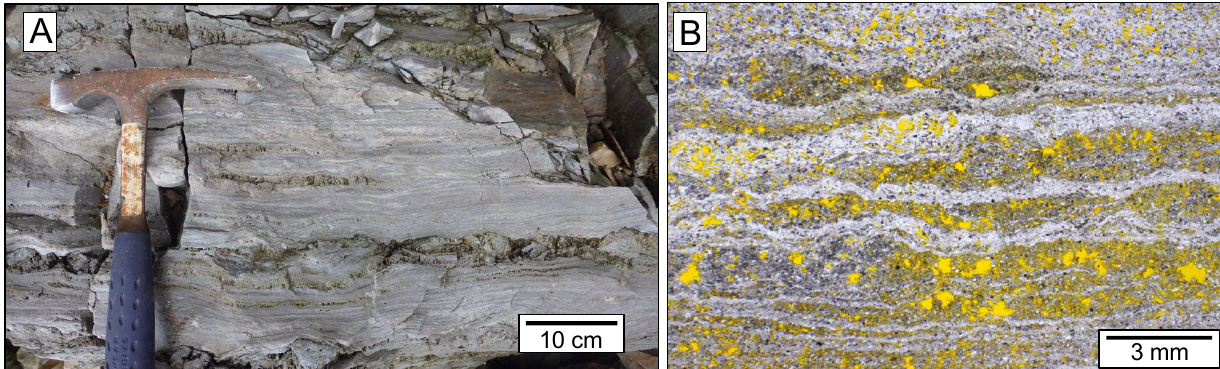
Figure 14: [A] Photograph showing the vesicular lithofacies of Shiroyama lava in the Teishi area. Dense flow bands are developed. [B] Plane-polarized photomicrograph showing the flow bands. Black bands of this photomi- crograph correspond to the light-colored bands in the